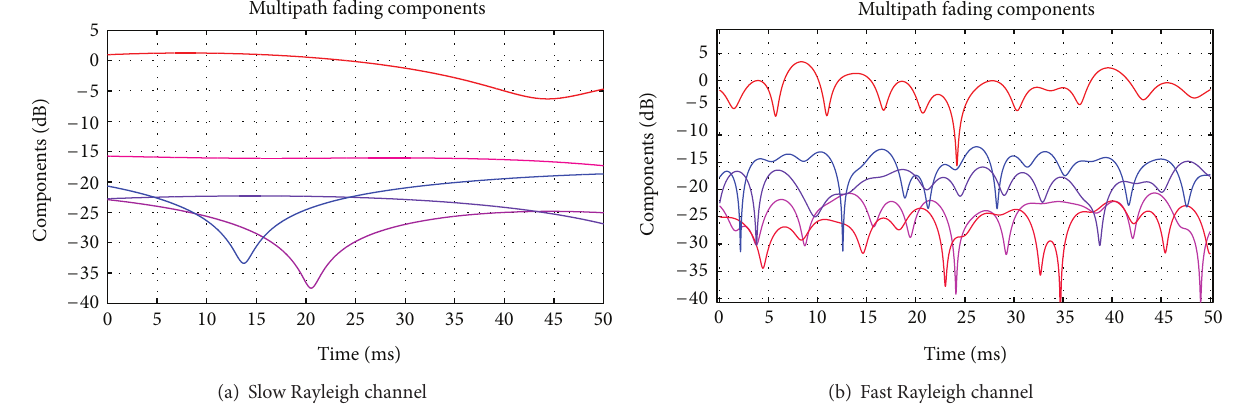
(b) Fast Rayleigh channel